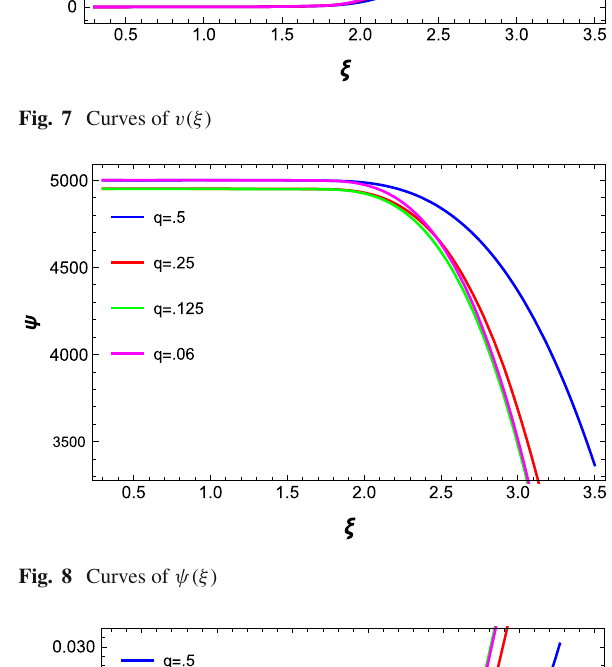
Fig. 8 Curves of ψ(ξ)